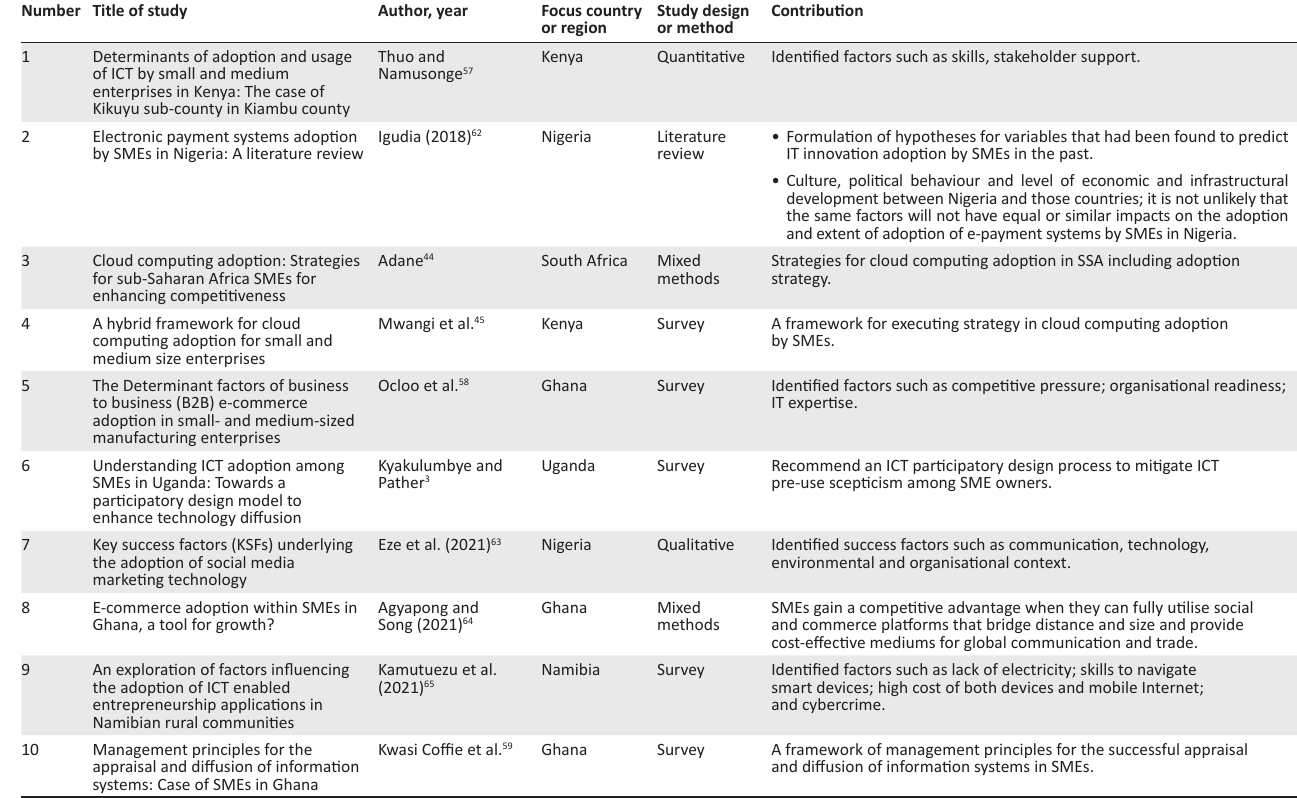
TABLE 2: Sample of studies on digital technology use by small and medium enterprises in the sub-Saharan Africa